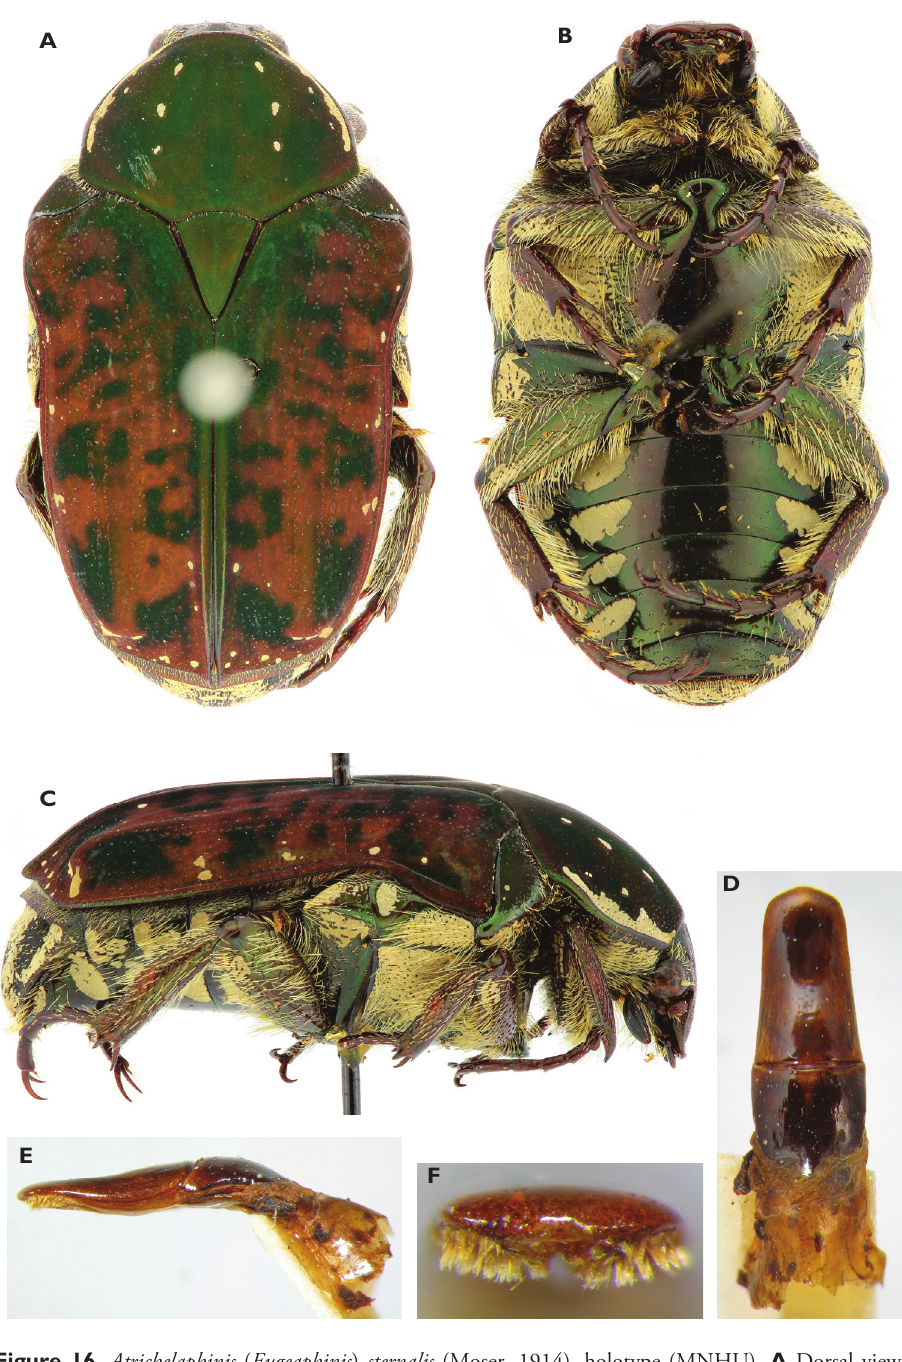
Figure 16. Atrichelaphinis ( Eugeaphinis ) sternalis (Moser, 1914), holotype (MNHU). A Dorsal view B ventral view C lateral view D parameres in dorsal view E parameres in lateral view F apex of